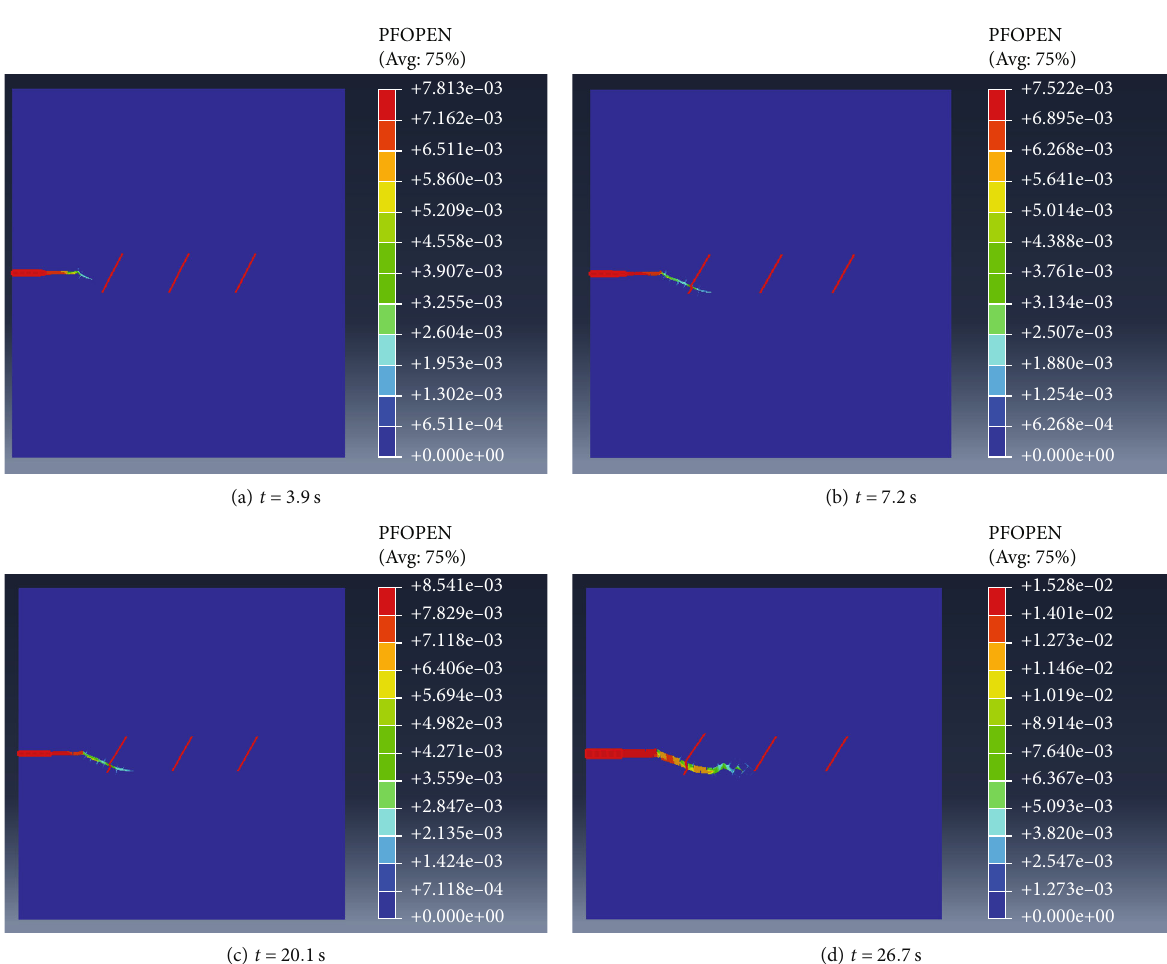
Figure 35: HF propagation at the NF approaching angle of 60 ° and under a stress anisotropy coe ffi cient of 0.2.